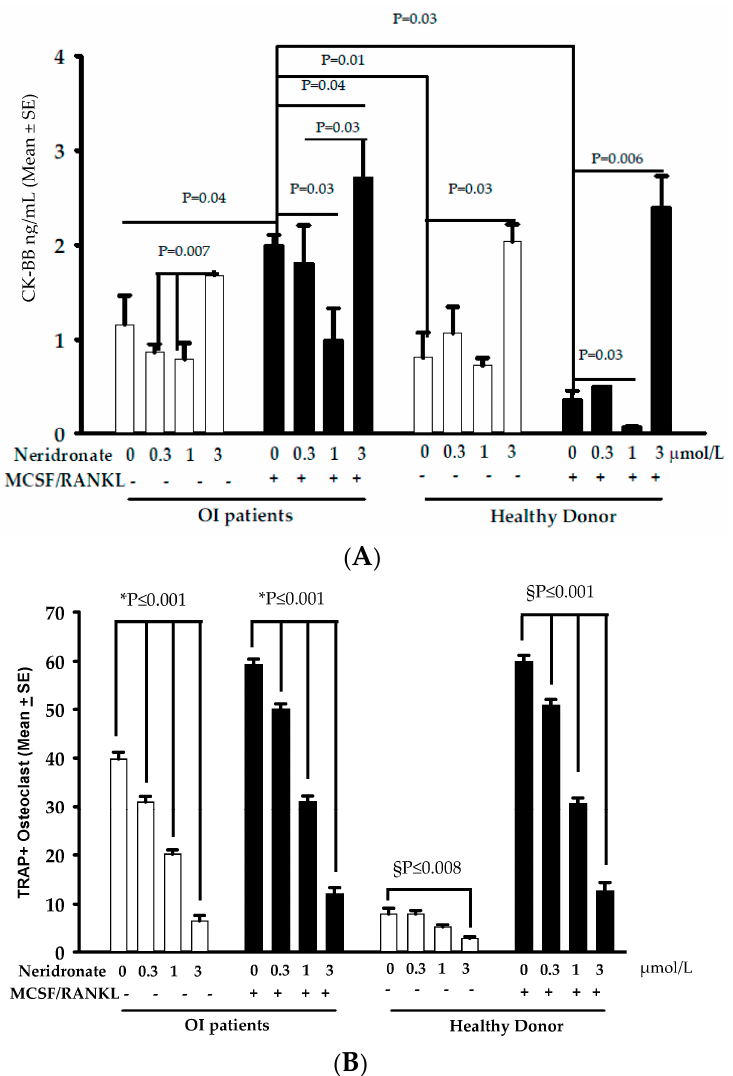
Figure 1. ( A ) CK-BB levels in media of osteoclast cultures and ( B ) number of TRAP+ osteoclasts from a representative OI patient and a representative healthy donor treated with different concentrations of neridronate. Each treatment was performed in quintuplicate replication, and each bar reports the results as mean ± SE. * and § are referred to as 0 neridronate.